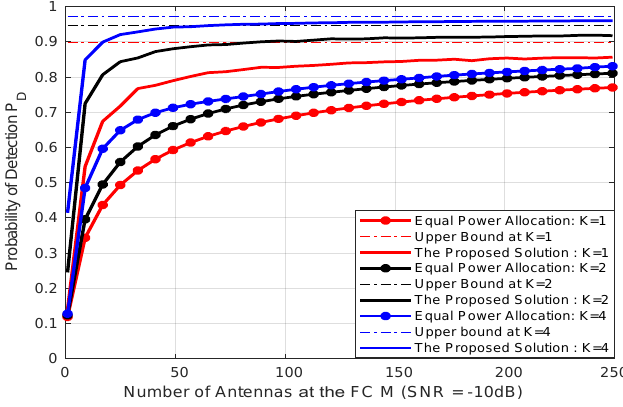
Figure 6. P D vs. M for comparison of different methods of detection performance.